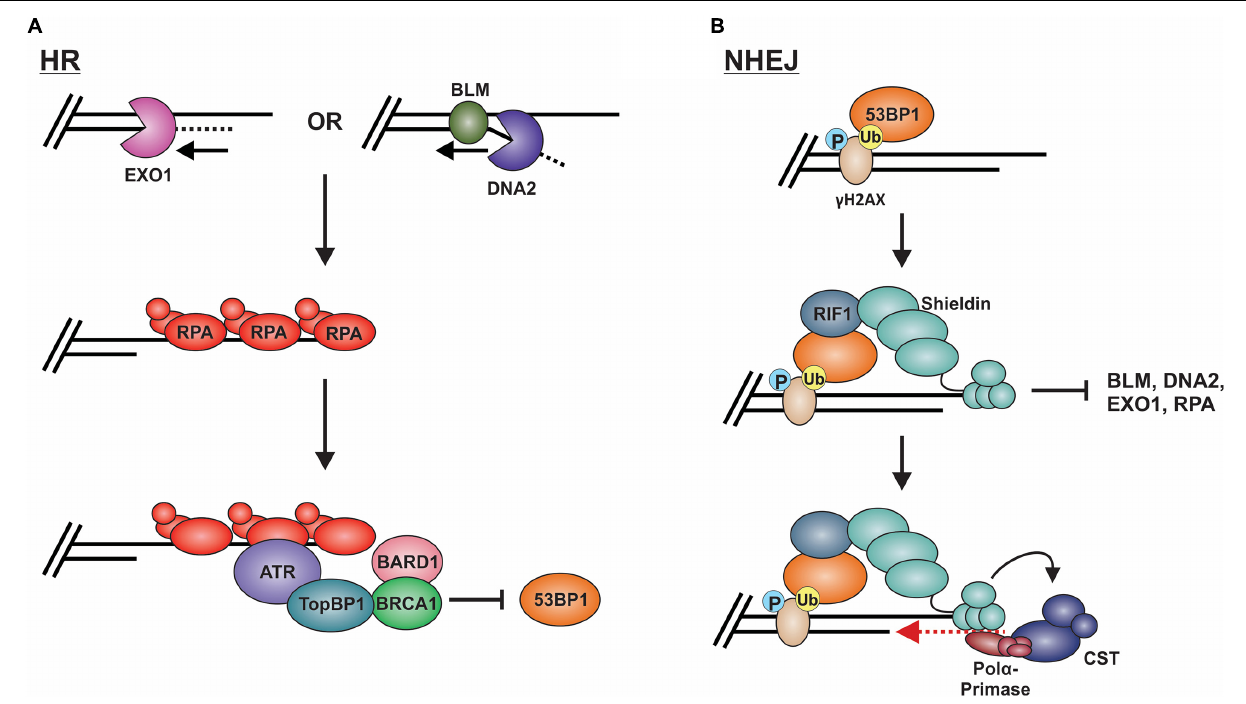
FIGURE 8 | Models of long-range resection and how long-range resection is inhibited/reversed. (A) Long-range resection is mediated by EXO1 or BLM/DNA2. The resulting ssDNA is bound by RPA, which serves as a platform for ATR binding. To inhibit NHEJ, TopBP1 bridges interactions between ATR and the BRCA1-BARD1 complex, blocking 53BP1. (B) 53BP1 is localized to DSBs through its interaction with specific histone marks. 53BP1 then interacts with RIF1, which localizes the shieldin complex. Shieldin inhibits long-range resection by preventing access to the resected DNA and reverses resection through its interaction with CST-pol α , which can mediate fill-in of the resected DNA. This promotes repair of the break by NHEJ. (P: phosphorylation; Ub: